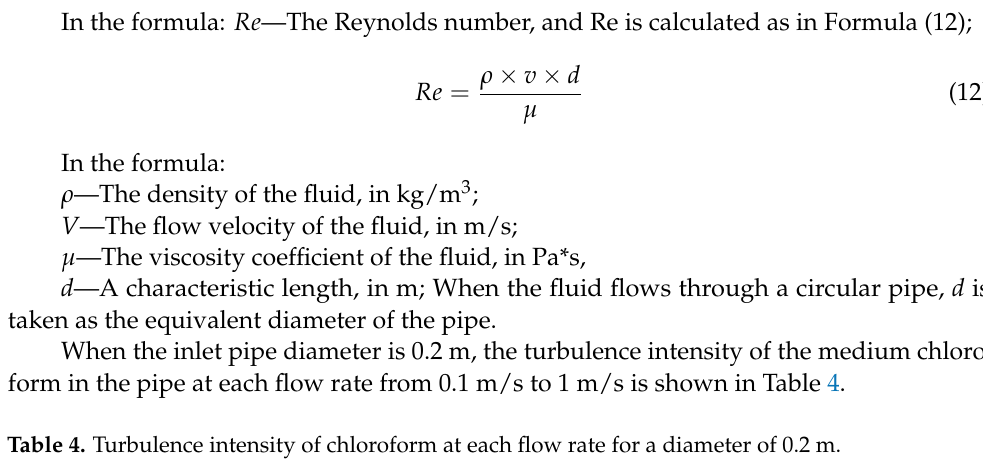
Table 4. Turbulence intensity of chloroform at each flow rate for a diameter of 0.2 m. Flow Rate